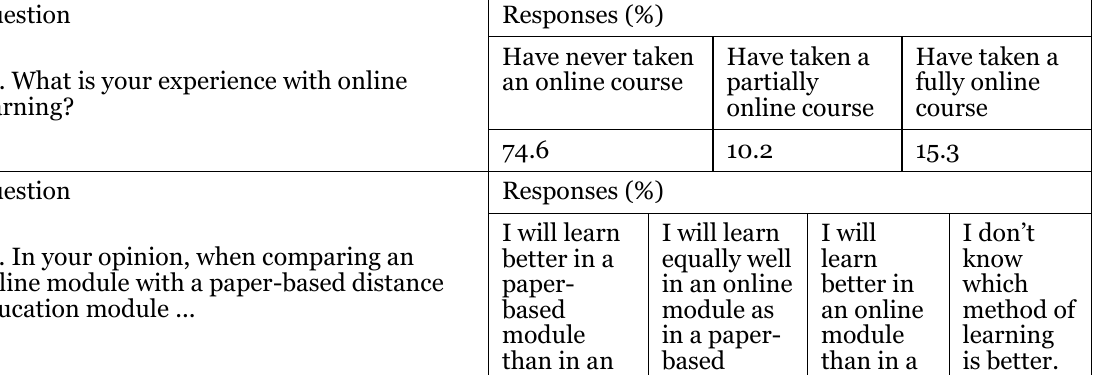
Figure 4. Responses to location and type of technological